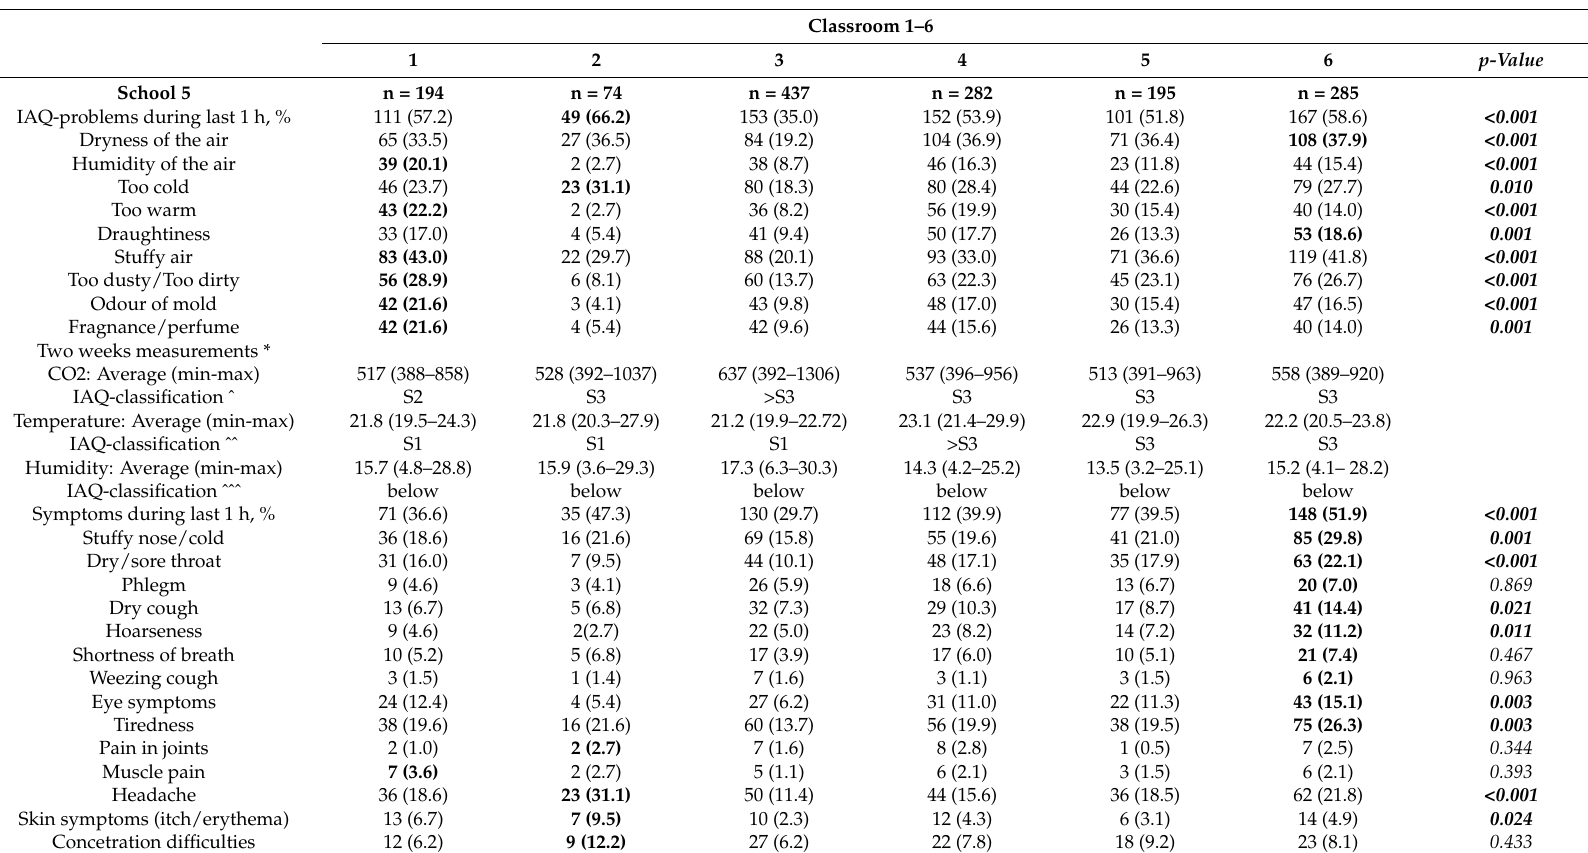
Table 8. Differences between the classrooms in the IAQ problems and symptoms during last hour among pupils and results of CO 2 , temperature, and relative humidity measurements in school